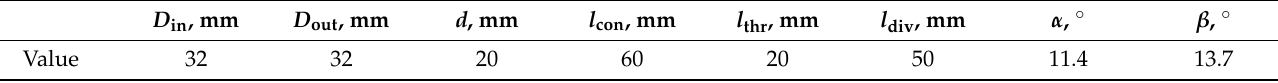
Table 1. Dimensional details of Venturi tube from Caetano et al.